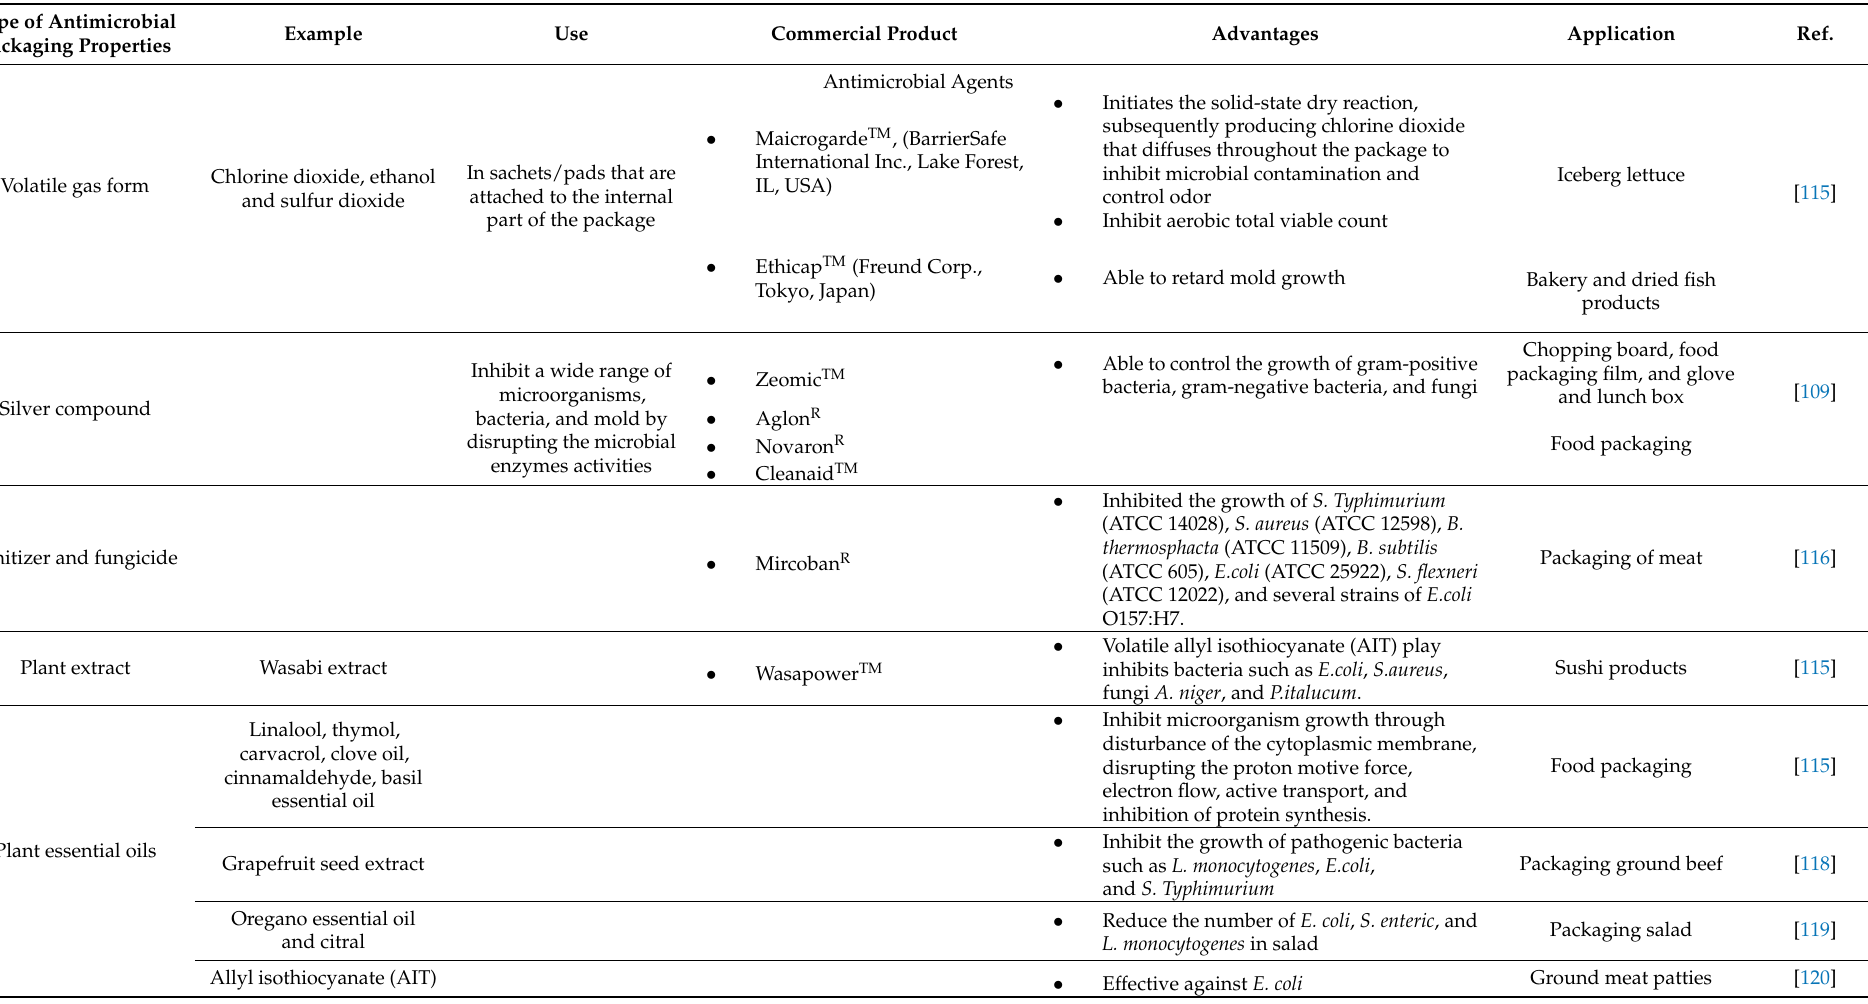
Table 4. Use, Advantages, and Applications of Different Types of Antimicrobial Properties in Antimicrobial Packaging for Food